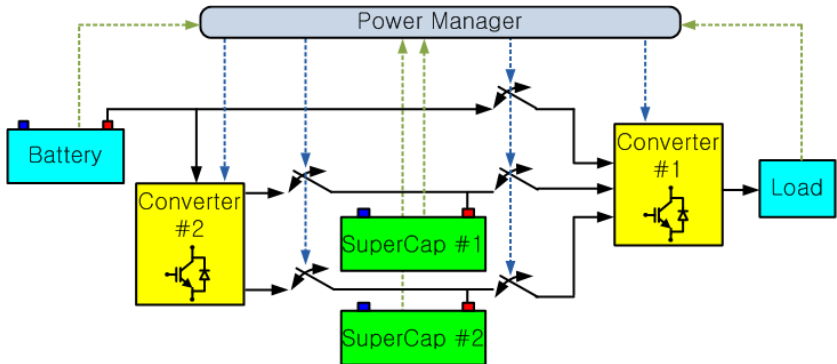
Figure 1. Structure of a typical portable hybrid power supply